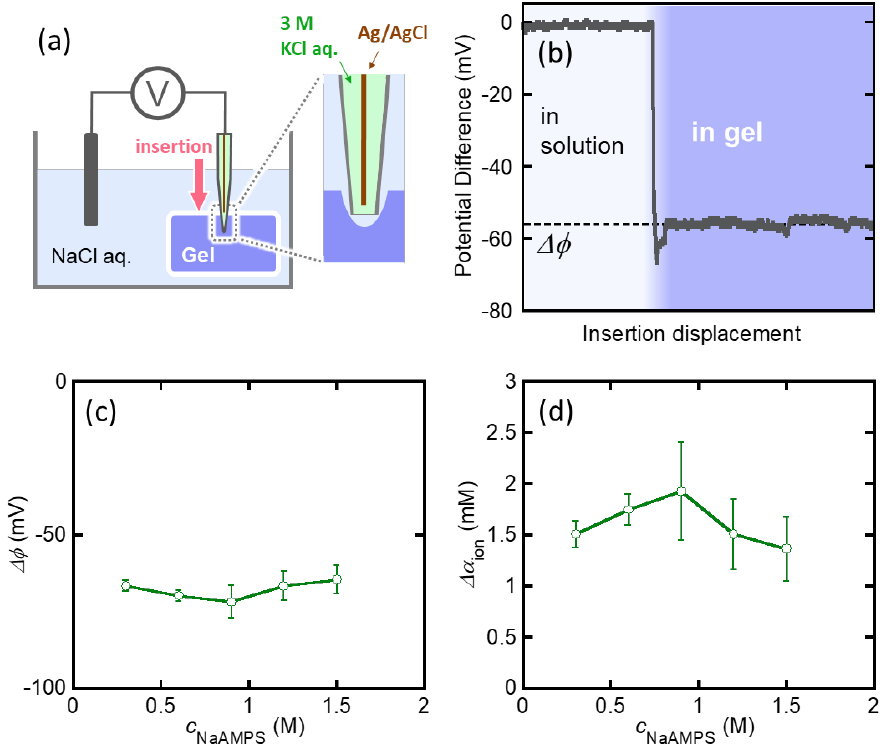
Figure 4. ( a ) Schematic illustration of how to perform the electric potential measurement; ( b ) a typical potential difference–insertion displacement curve; ( c ) effect of c NaAMPS on Δ𝜙 of the St-tetra-PEG gels in a 10 −4 M NaCl aqueous solution; and ( d ) Δ𝛼 ion of the St-tetra-PEG gels in a 10 −4 M NaCl aqueous solution.